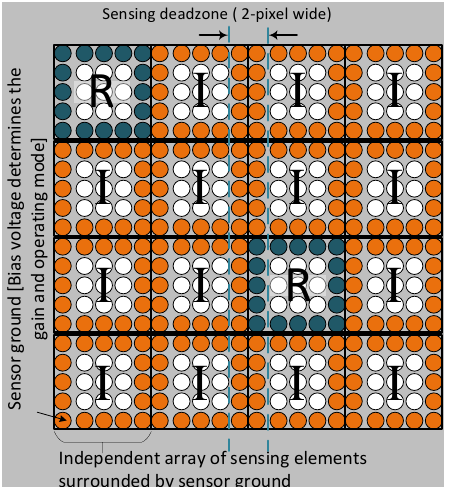
Figure 3. Concept of a reconfigurable sensor with an array of independently controlled segments, where each segment has an array of sensing pixels surrounded by a sensor ground. Changing the sensor bias voltage changes the internal gain of the sensor. Regions with a lower internal gain (orange) can be used as an imager (photon counting) and those with high gain (blue) can be used as a ranger (photon time of arrival). In this format the ground contacts lead to minimal dead zones or gaps between sensing areas, which can be designed to be <1% of the active